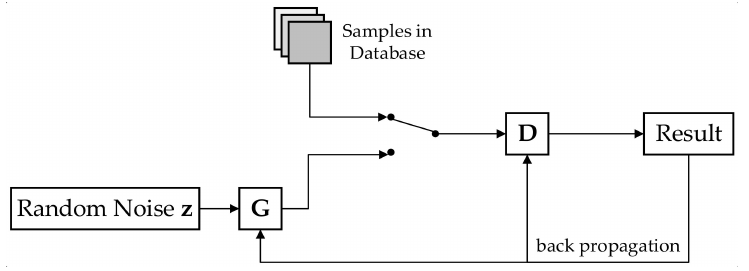
Figure 1. The basic structure of